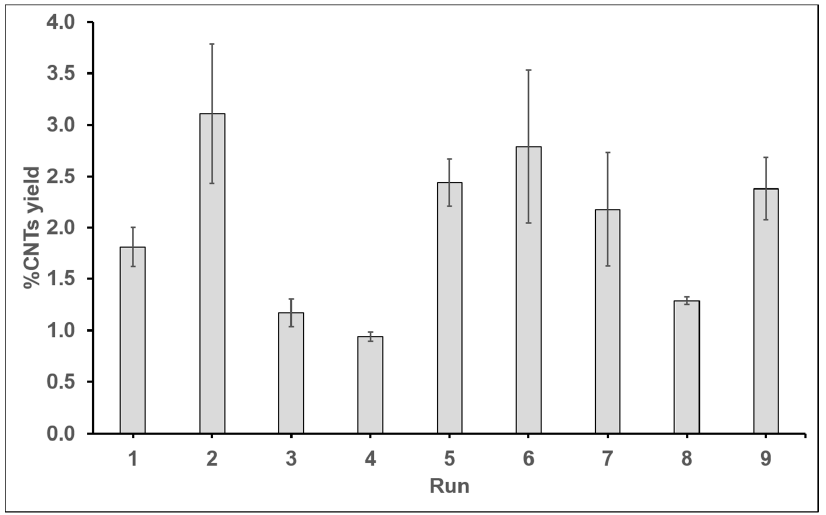
Figure 1. Carbon nanotube yield and standard error for each run of experiments.